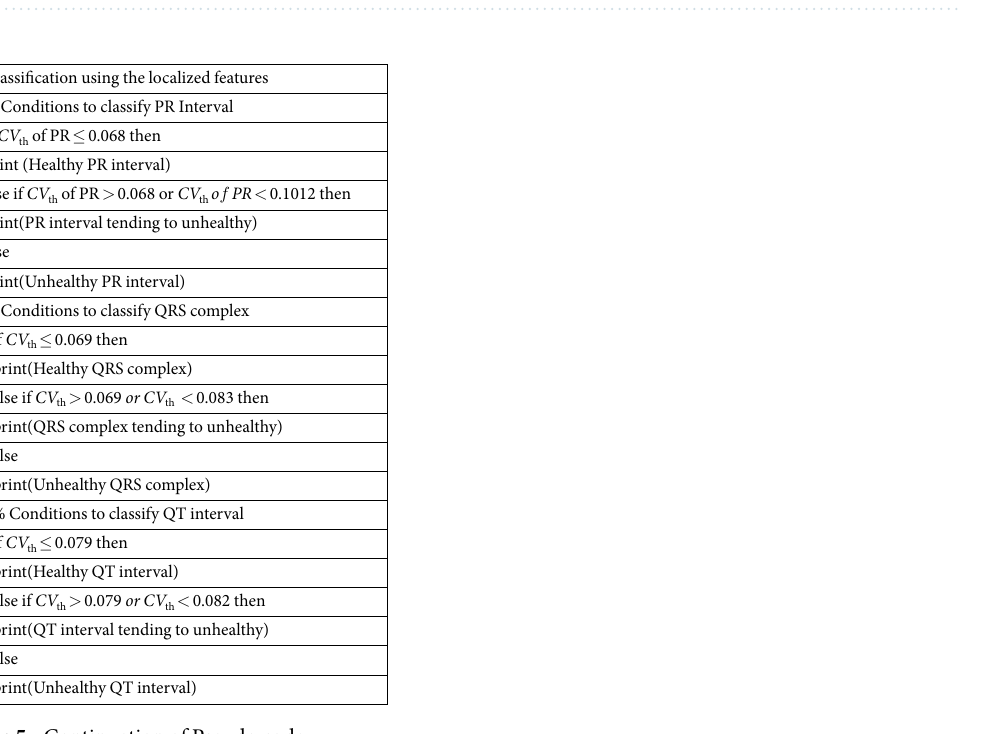
Table 4. Pseudo code of the proposed methodology to find CV of ECG localized